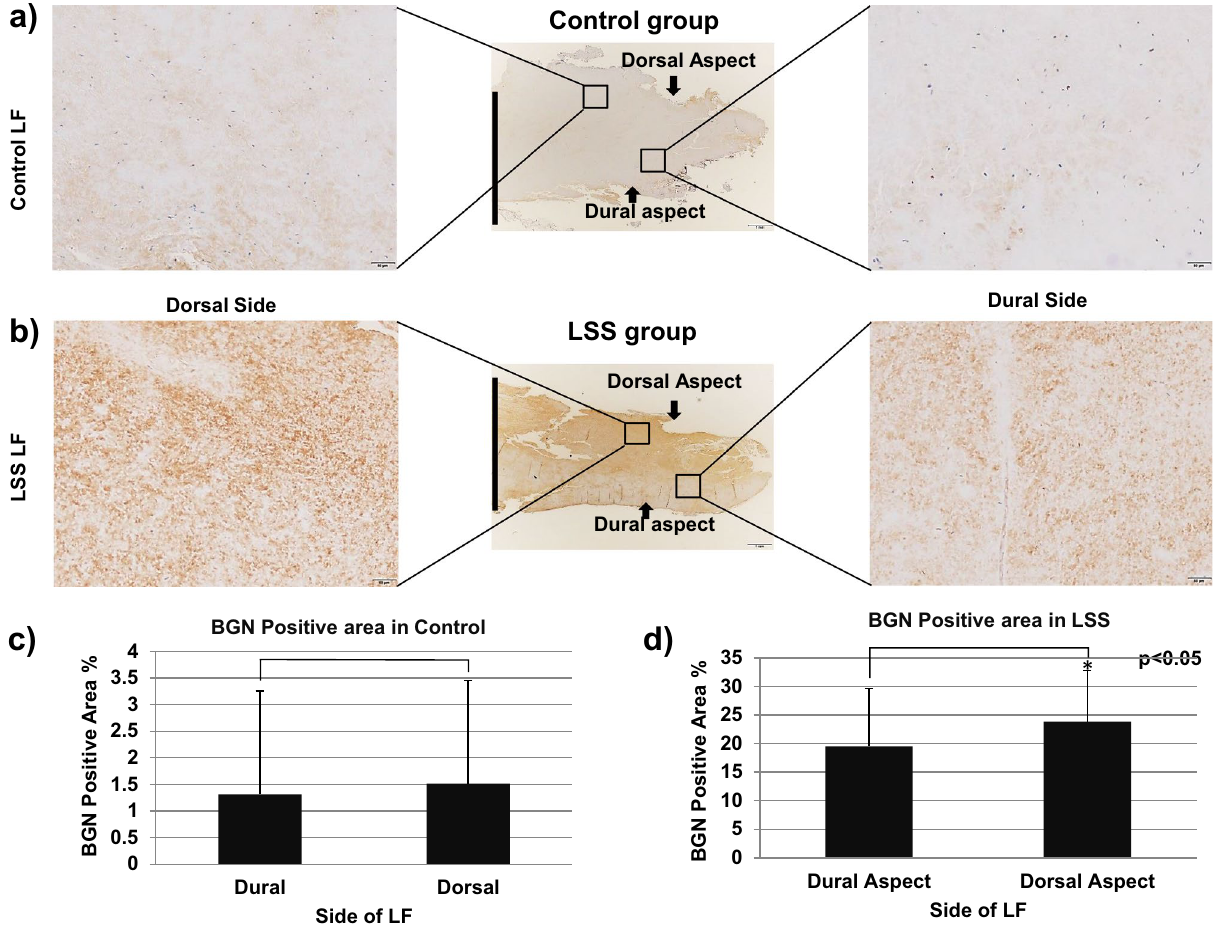
Figure 4. The comparison of immunohistochemistry for BGN between dorsal side (left) and dural side (right) in ( a ) non-hypertrophied (control) LF and ( b ) hypertrophied LF, and the percentage of BGN-positive area in each area of ( c ) non-hypertrophied (control) LF and ( d ) hypertrophied